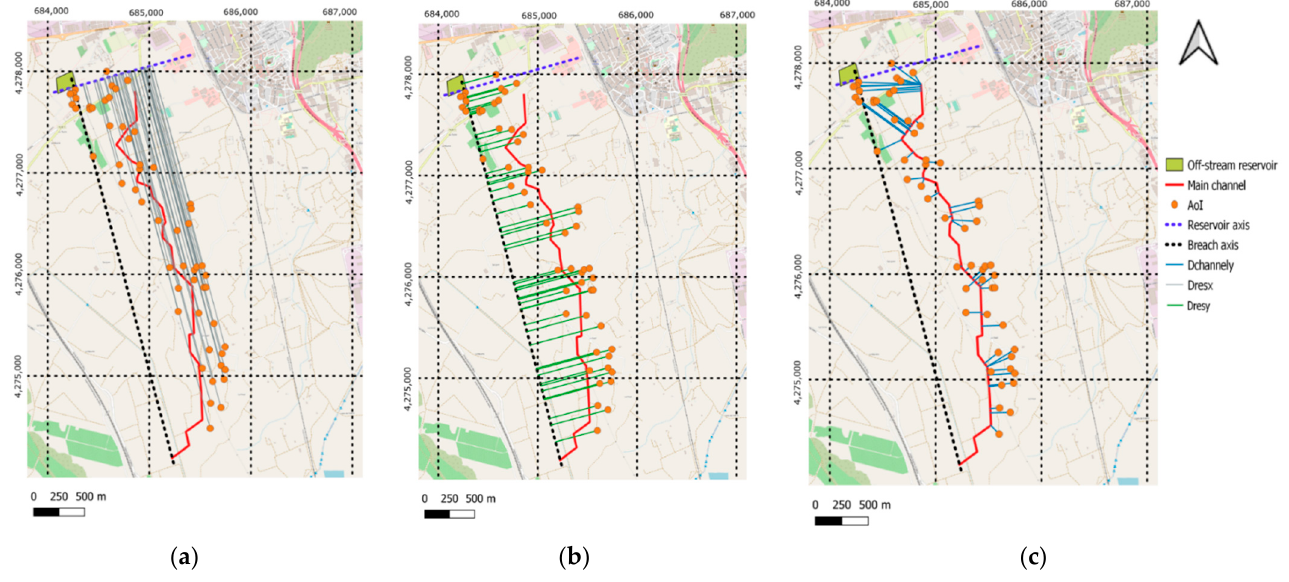
Figure 13. Parametrization AoI. ( a ) Distance between AoI and reservoir axis (D resx ). ( b ) Distance between AoI and breach axis (D resy ). ( c ) Distance between AoI and main channel (D channely ). Axes represent UTM coordinates.